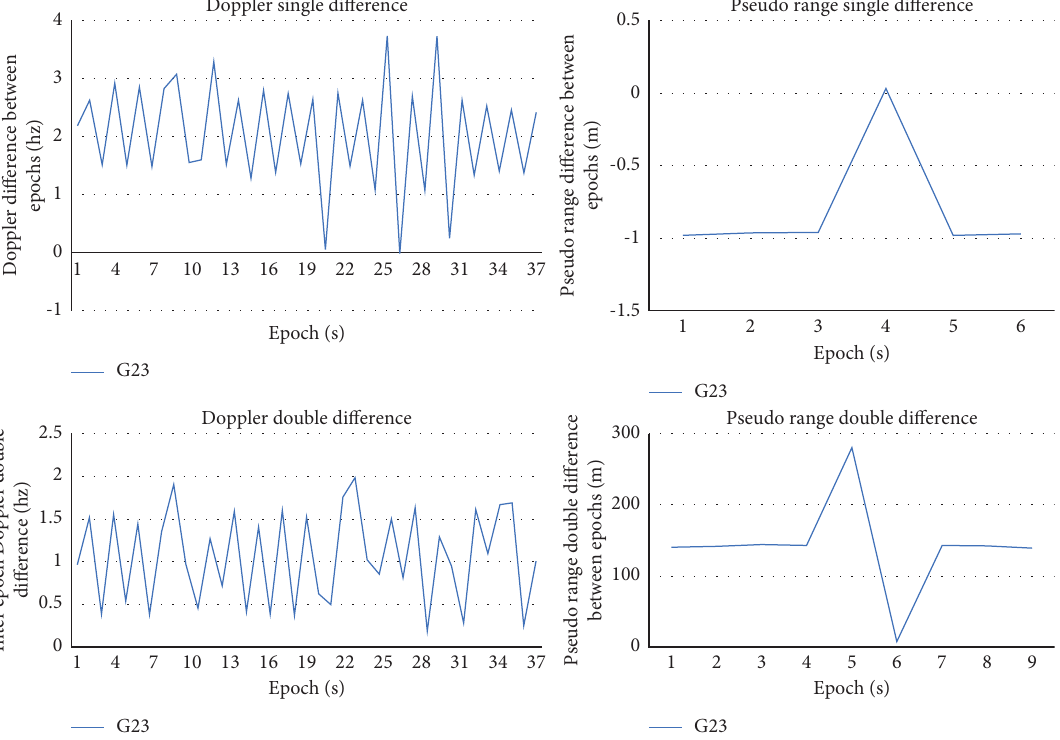
Figure 7: Doppler diference and pseudorange diference between the ephemerides of the G23 satellite. (a) Doppler single diference. (b) Pseudorange single diference. (c) Doppler double diference. (d) Pseudorange double diference.